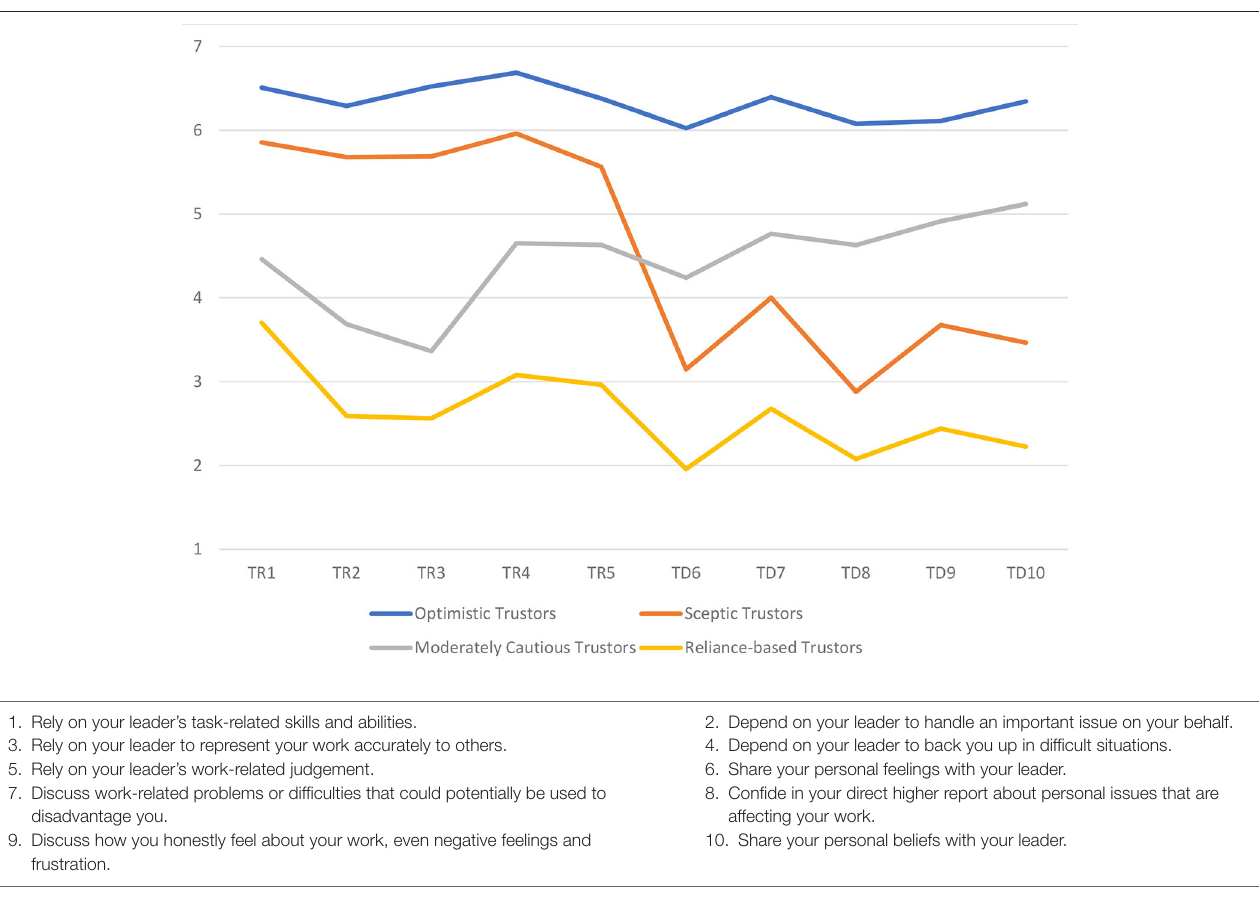
FIGURE 1 | Four latent profiles based on 10 items of the